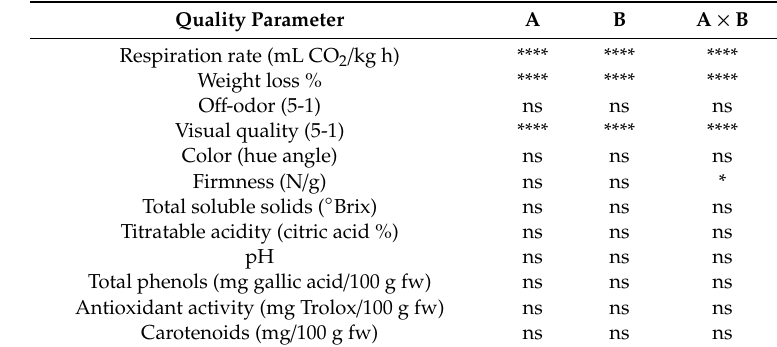
Table 3. Quality parameters evaluated in blueberries ( Vaccinium corymbosum L., cv Rebel ) at harvest. Data are mean of three replicates ± standard deviation.